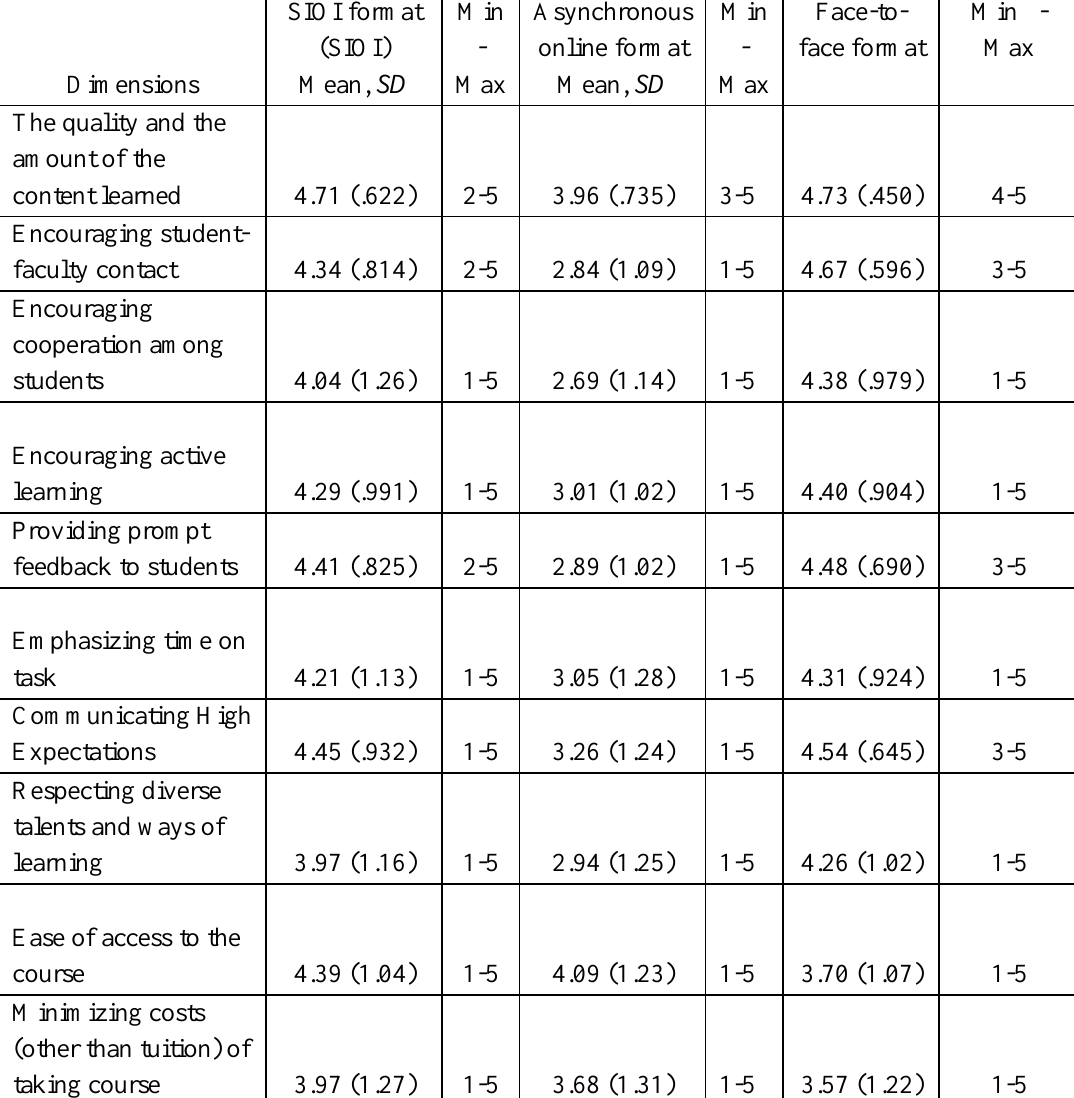
Table 6 Mean Student Ratings of the Quality of Course Formats Relative to Dimensions of